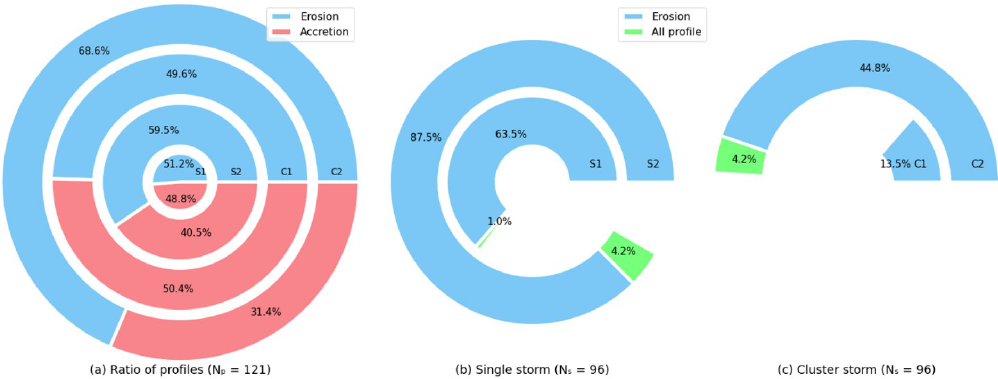
Figure 7. Ratio of erosion (blue) and accretion (red) profiles out of the total number of profiles ( N p = 121) ( a ) and the ratio of model skill, corresponding to BSS ≥ 0.3 out of 96 simulations ( N s = 96) for single storm ( b ) and cluster storm ( c ) events. These ratios are calculated in erosion (blue), accretion (red), and all 121 profiles (green), respectively. It should be noted that none of the BSS calculated in accretion profiles exceeds the threshold value (0.3).